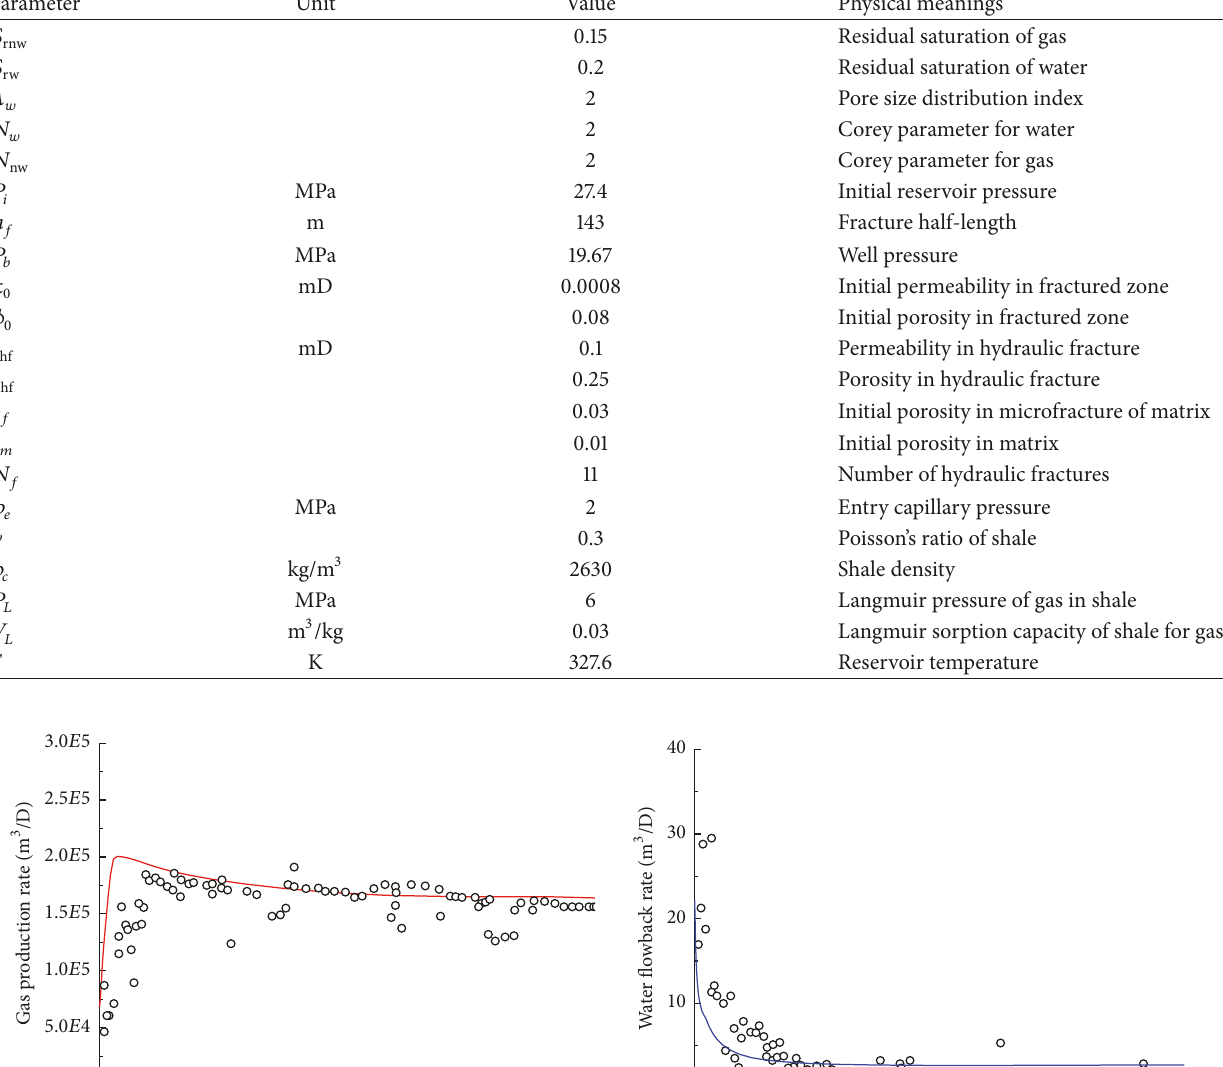
Table 2: Simulation parameters for field data.